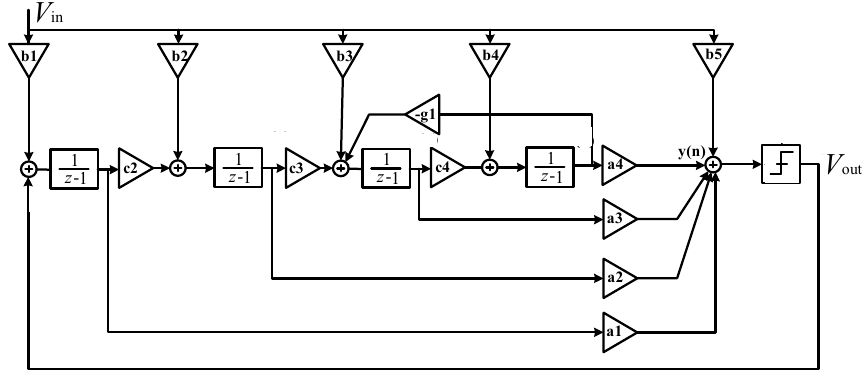
Figure 17. Schematic diagram of a fourth-order CIFF modulator.